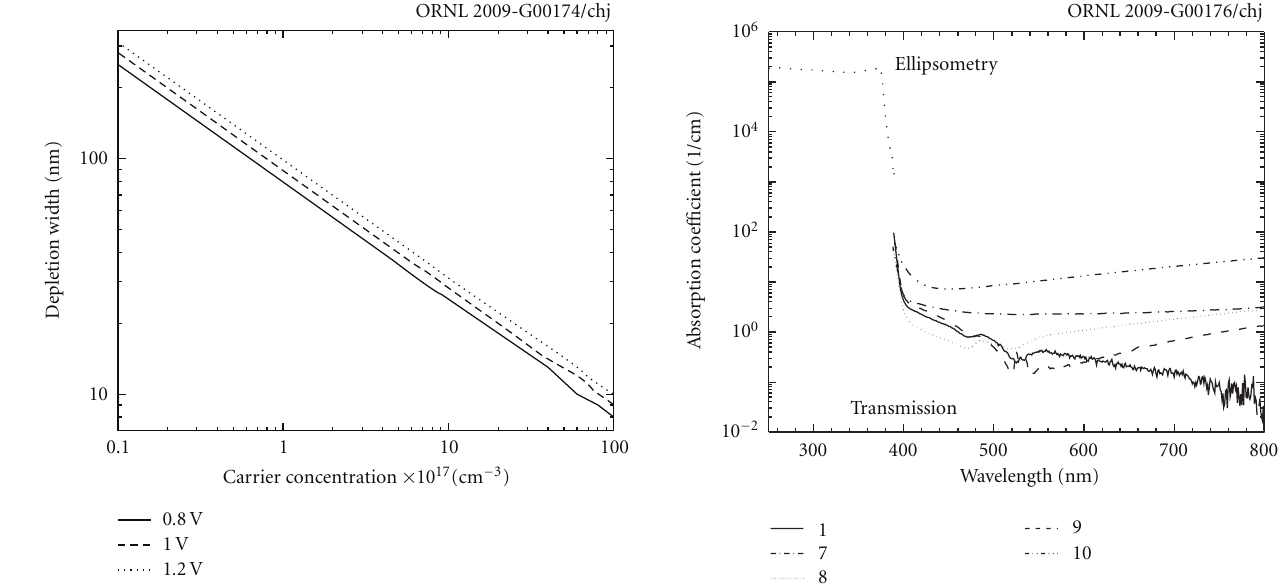
Figure 14: Absorption coe ffi cient as a function of wavelength for the indicated doped and undoped ZnO single crystals described